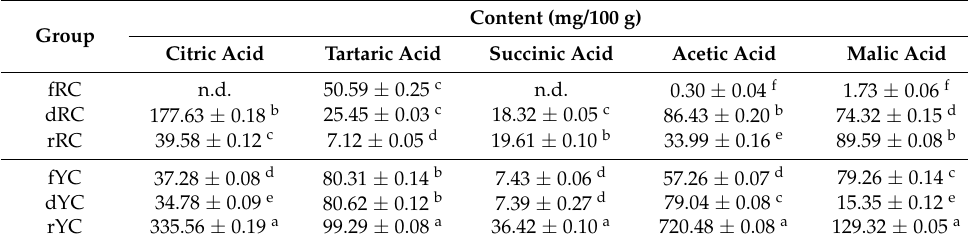
Table 4. Variation of organic acid pattern in differently treated polymorphic cacao beans *.